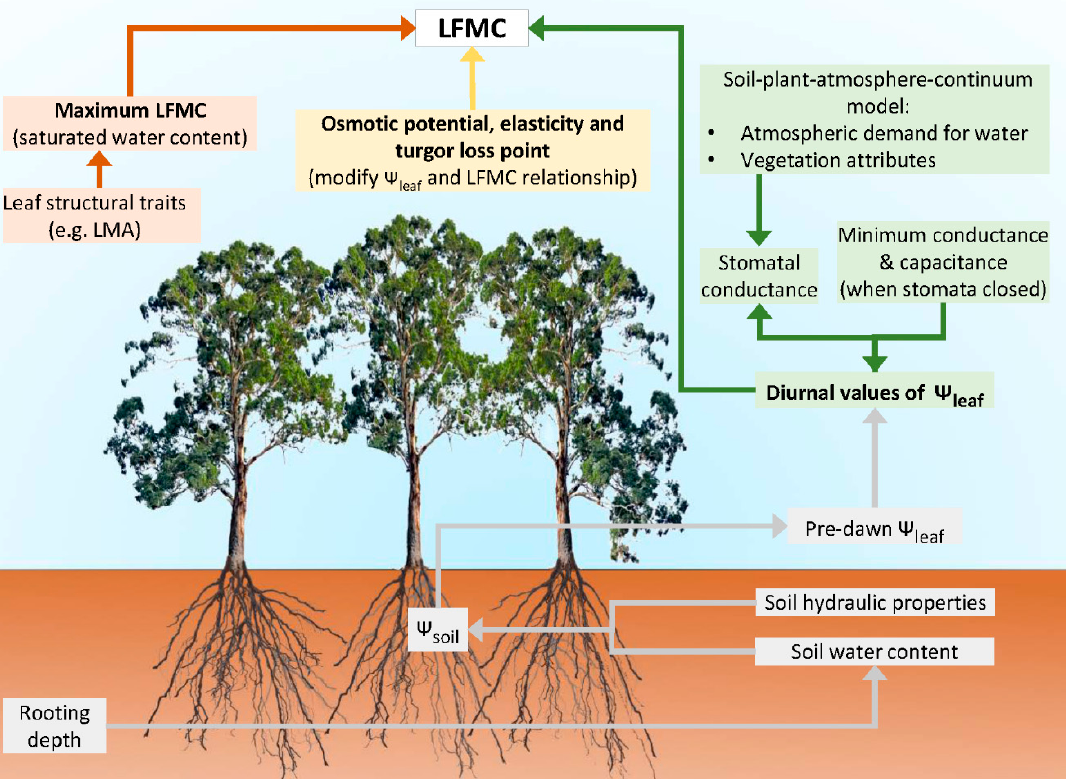
Figure 4. Overview of plant structural and physiological traits which modify the relationship between live fuel moisture content (LFMC) and soil water content. live fuel moisture content (LFMC) and soil water